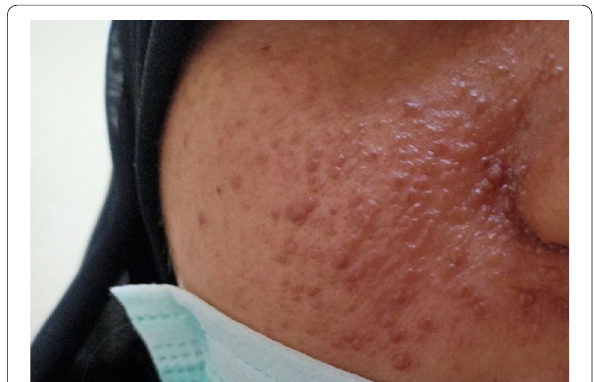
Fig. 1 Fascial angiofibromas